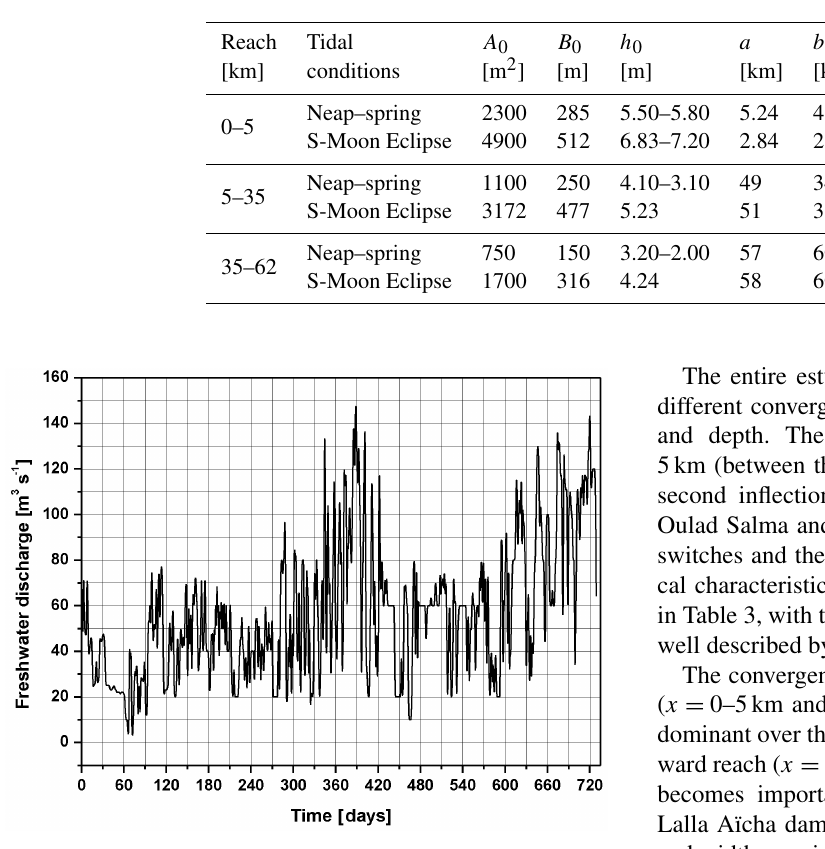
Figure 4. Freshwater discharge release by Lalla Aïcha dam (from 1 January 2014 to 1 January